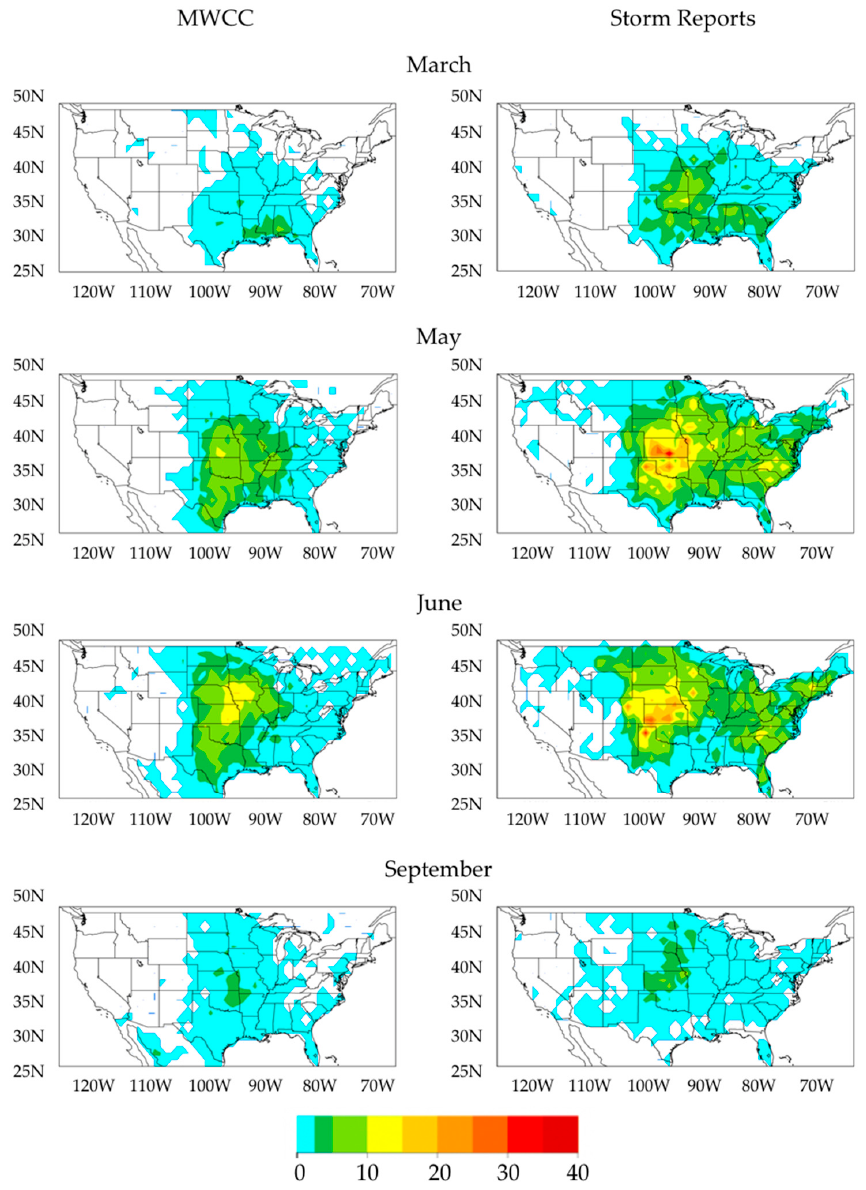
Figure 10. Twelve-year (2000–2011) mean number of hail events over CONUS for the months of March, May, June and September from MWCC-Hail retrievals ( left ) and official storm reports ( right ).